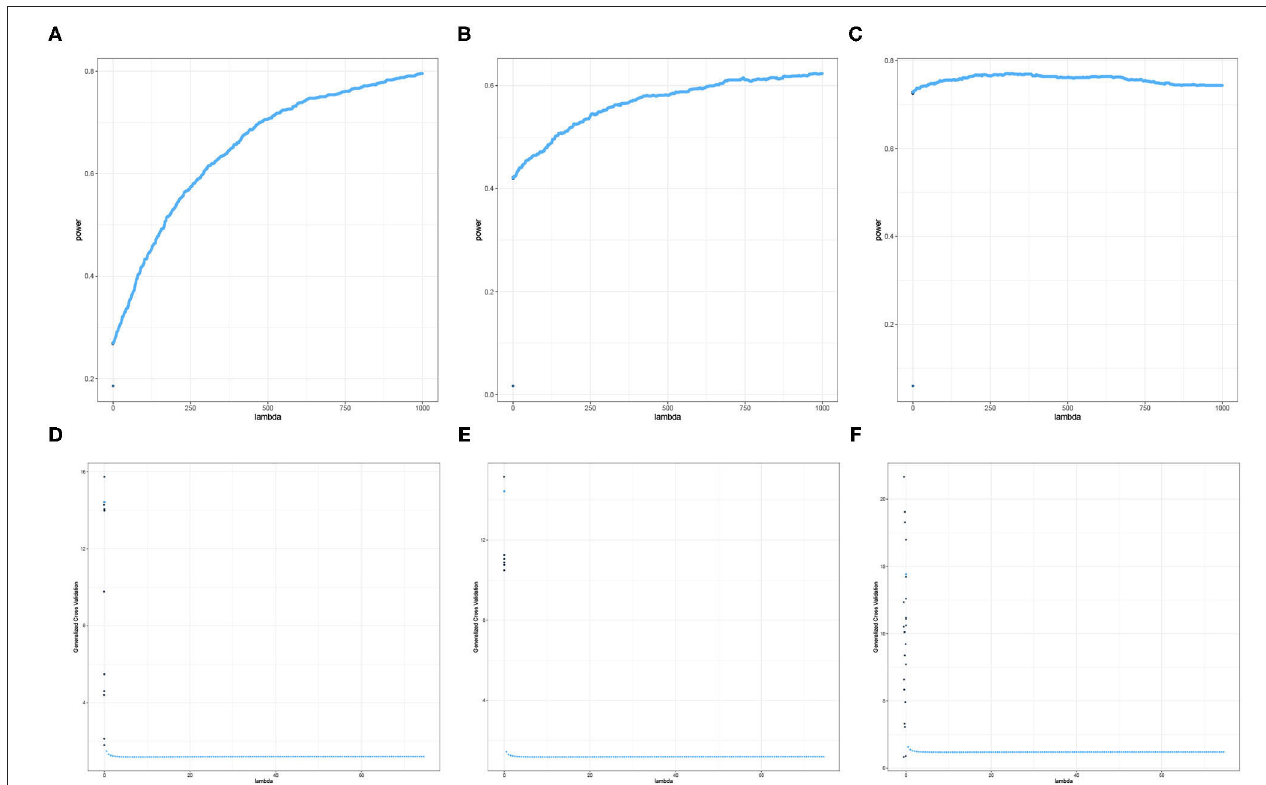
FIGURE 8 | Empirical Power and GCV plots of the Adaptive Mantel test for the imaging genetics data with n = 350 observations, p = 497 genetic features and coherence information from selected channel-channel-band triples with increasing power trend. (A) Power: FC3-P7-beta. (B) Power: F3-O2-alpha. (C) Power: Pz-PO4-alpha. (D) GCV: FC3-P7-beta. (E) GCV: F3-O2-alpha. (F) GCV: